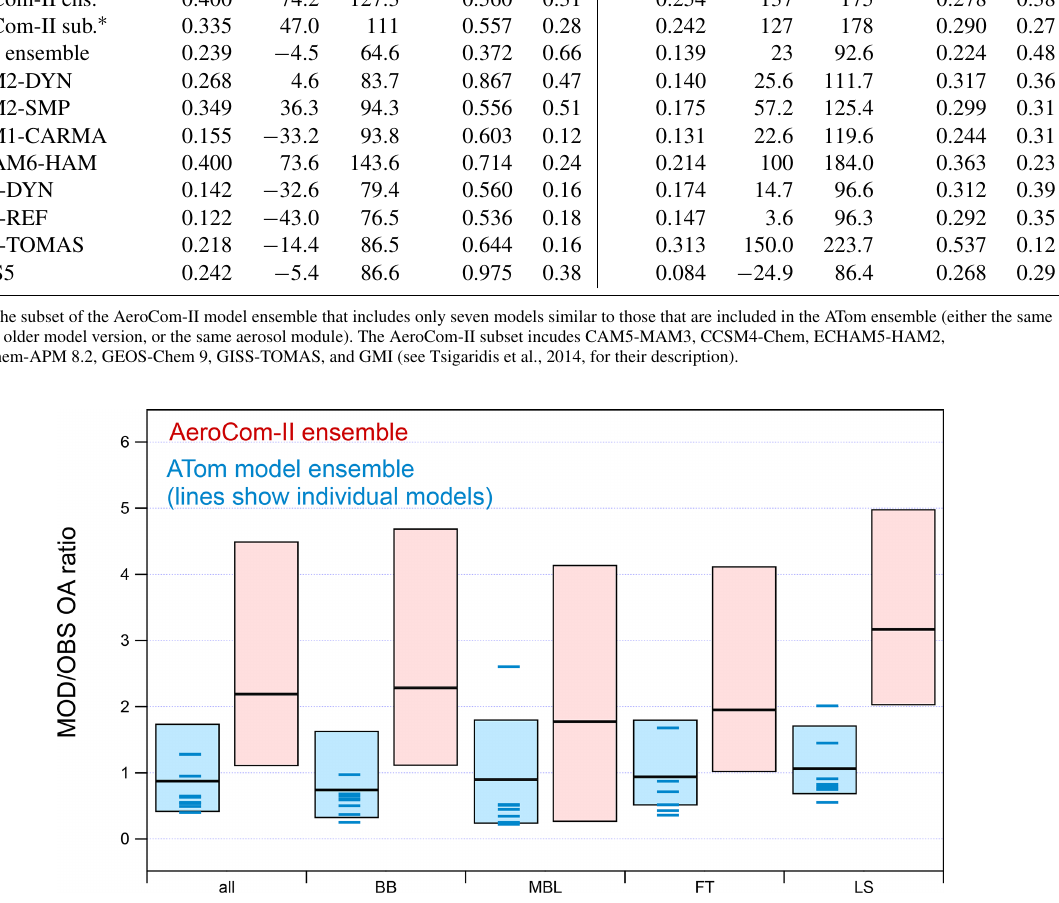
Figure 3. Ratios between predicted and observed OA concentrations for all ATom-1 flights as calculated for the ATom and AeroCom-II model ensembles in different regions (BB: biomass-burning-influenced regions; MBL: clean marine boundary layer; FT: clean free troposphere; LS: lower stratosphere). The median of the ensemble ratio is shown as a horizontal line, while the boxes indicate the 25th and 75th percentiles. Medians for the individual models included in the current ATom model ensemble are also shown as blue